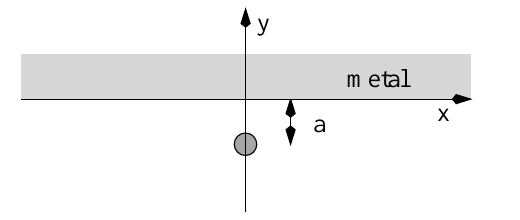
FIG. 3. Electron bunch passing close to a surface pipe.